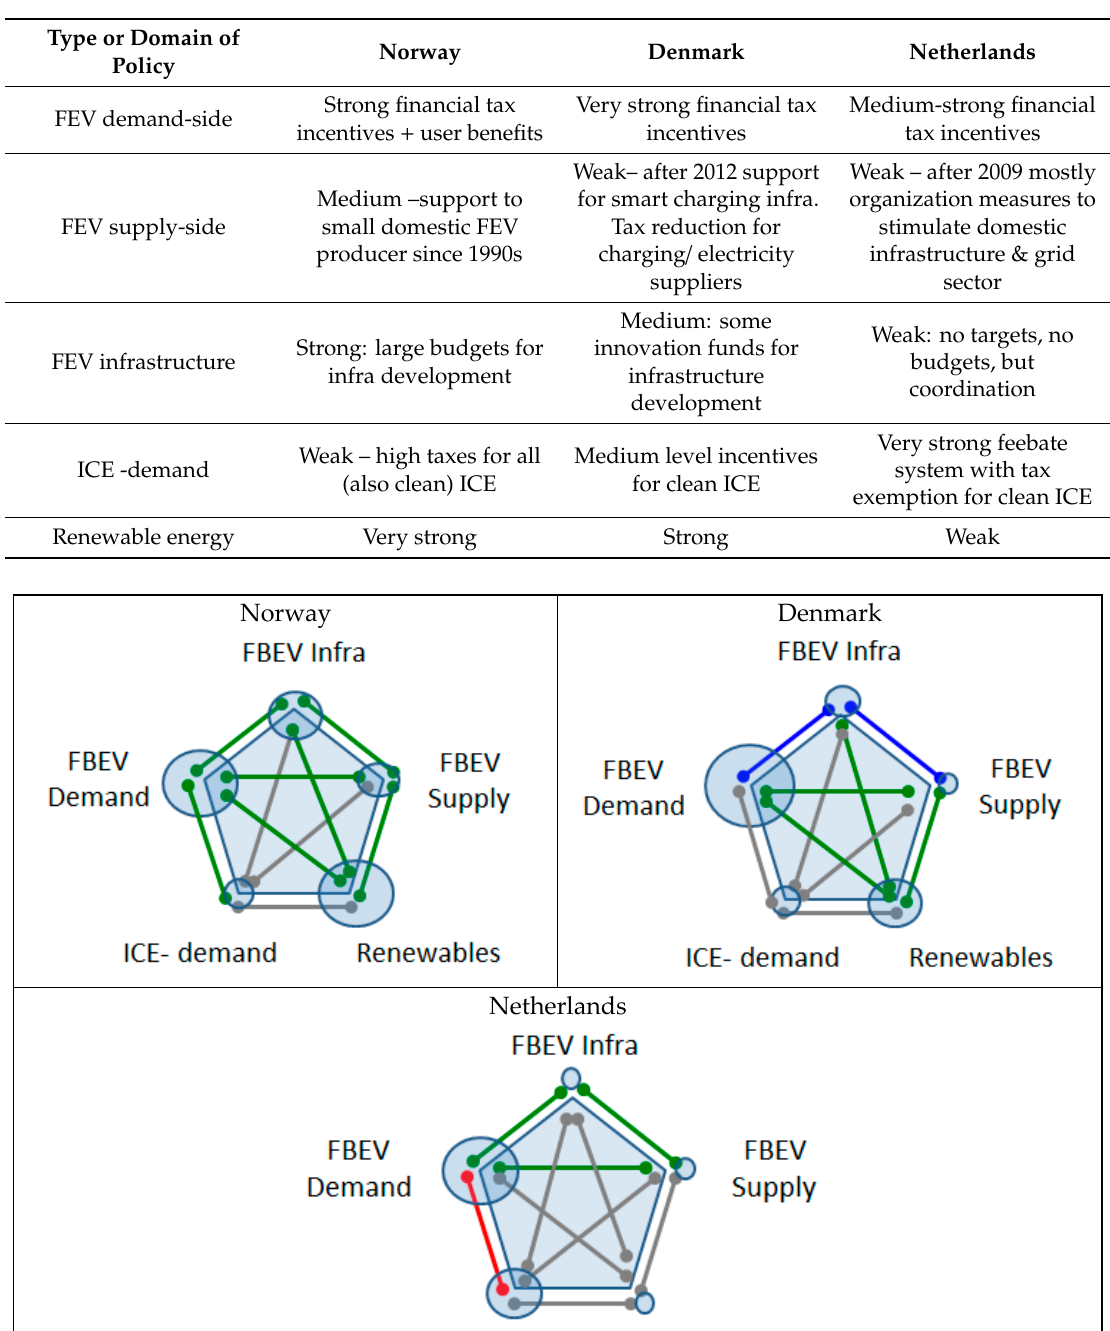
Table 6. Policy areas and their intensity.